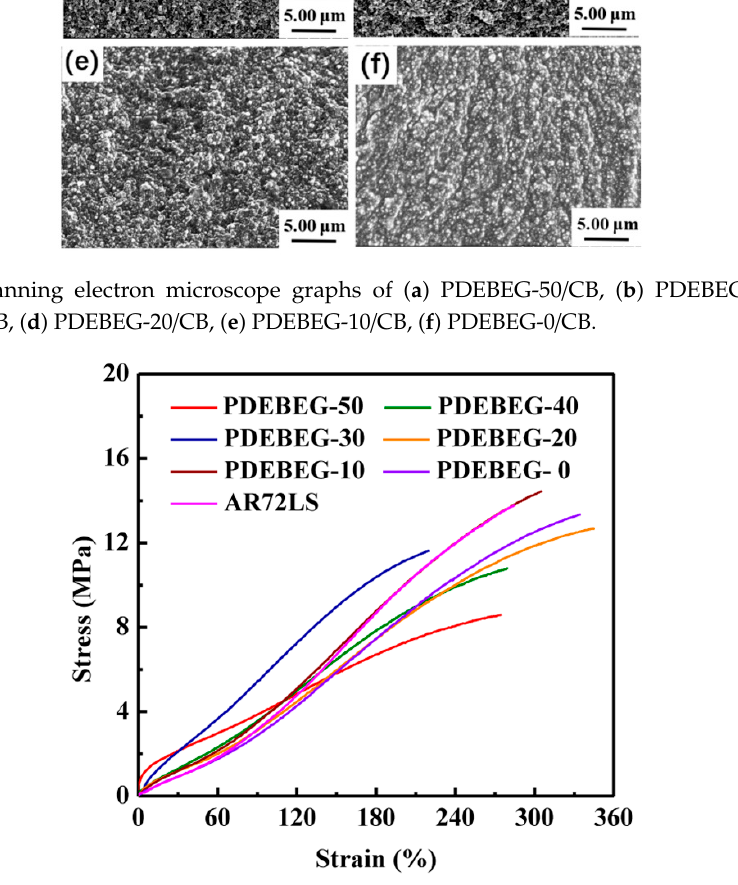
Figure 8. Scanning electron microscope graphs of ( a ) PDEBEG-50/CB, ( b ) PDEBEG-40/CB, ( c )